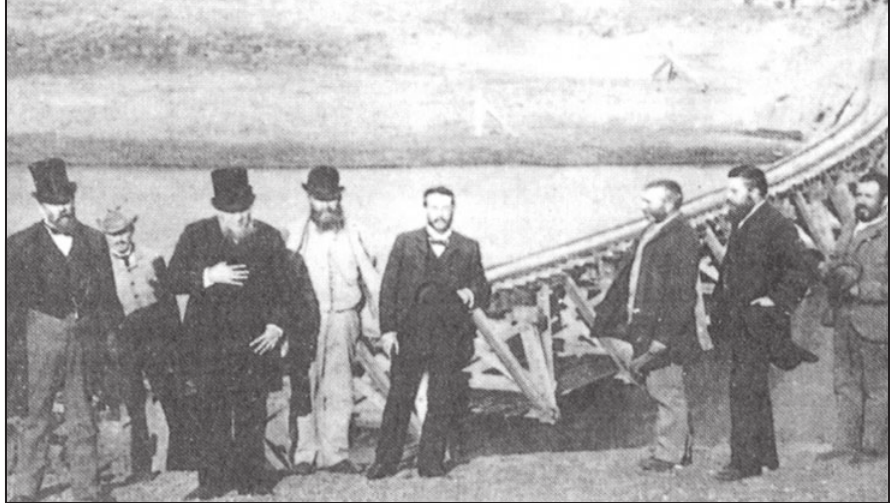
Illustration: In 1892 the railway bridge over the Vaal River at Vereeniging was taken into use. President Paul Kruger (third from left) and the entrepreneur Sammy Marks (third from right) at one point made plans to transport water in railway carriers to Johannesburg.